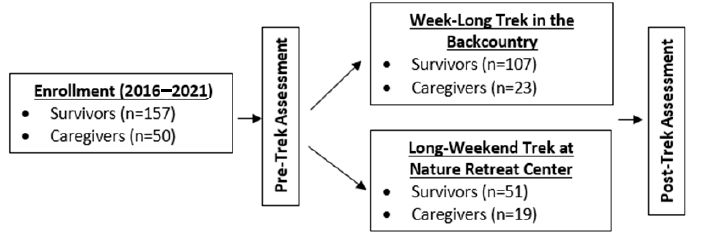
Figure 1. Study Flow.